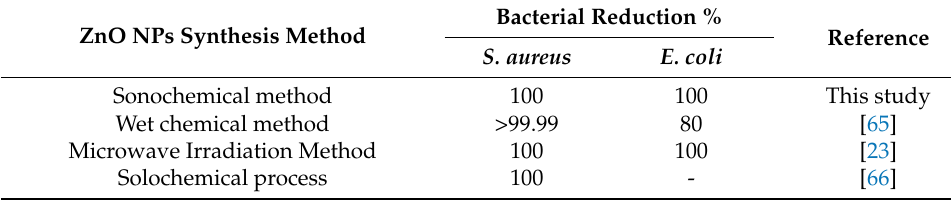
Figure 10. Bacterial reduction % vs. Zn contents. Table 6. Comparison of antibacterial activity.